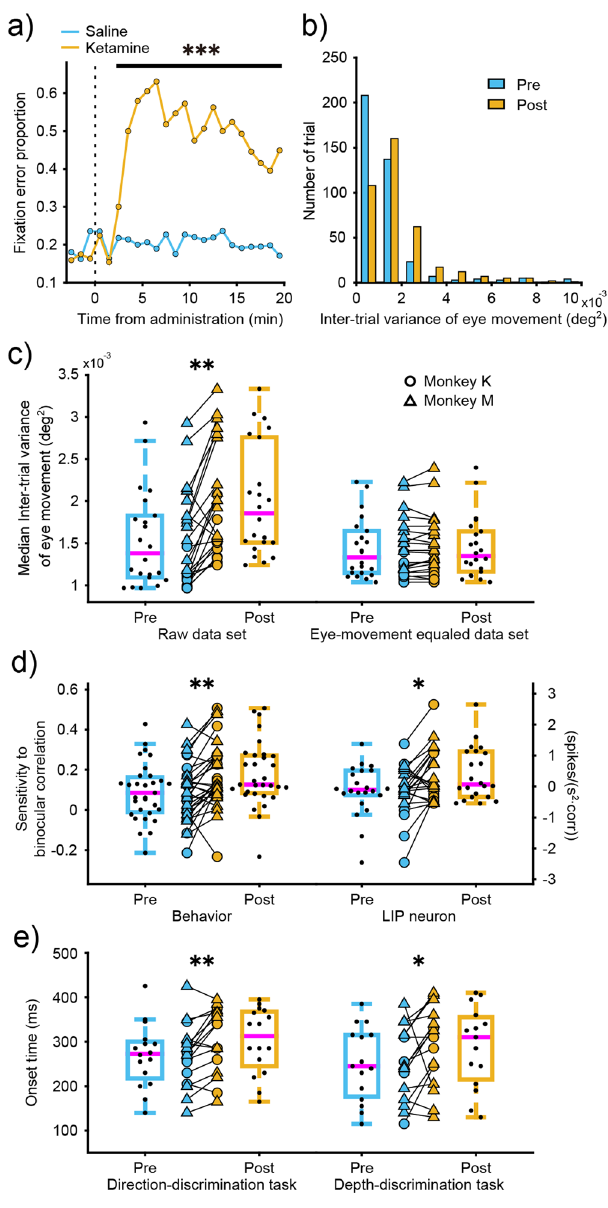
asymmetric effects of ketamine could be explained by the dif-